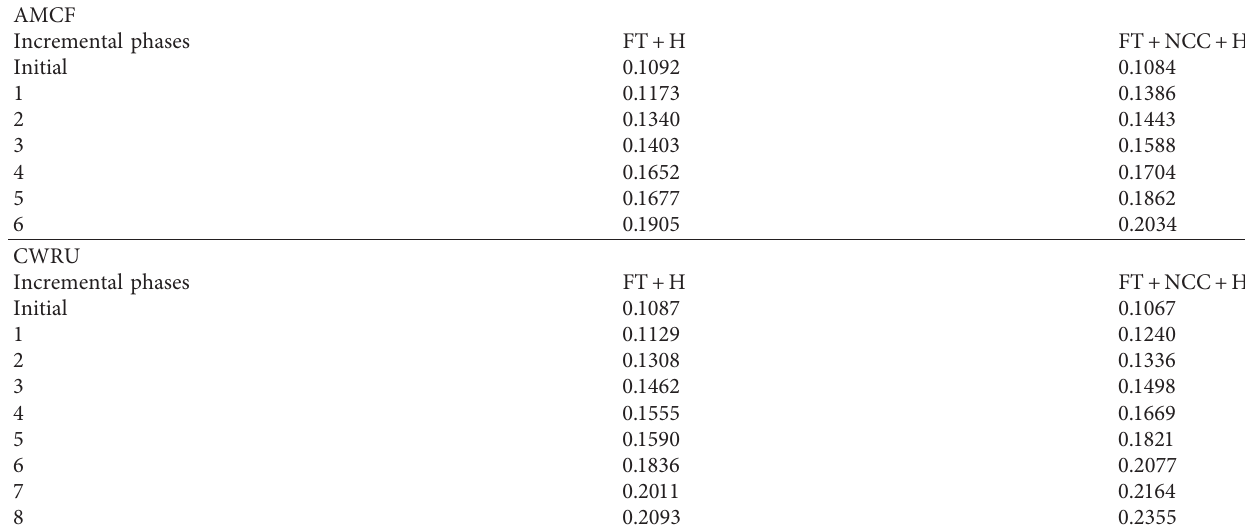
Table 8: Classification time (seconds) across different incremental phases.